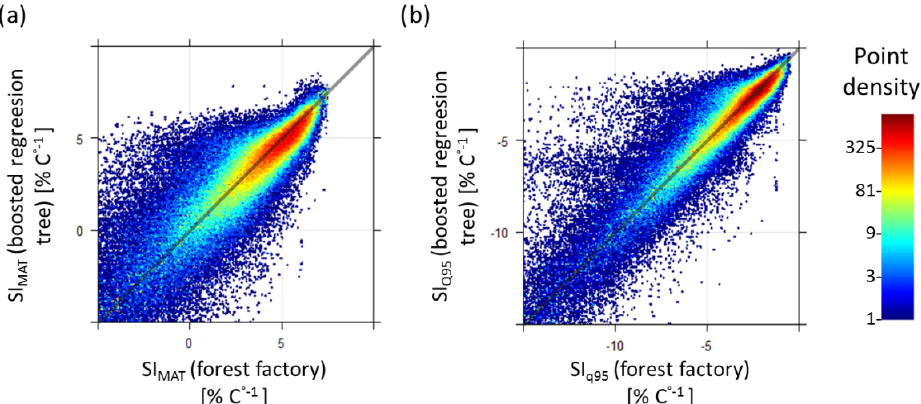
Figure B3. Comparison of temperature sensitivity calculations (SI MAT and SI Q 95 ) based on the forest factory and boosted regression tree model. Colours indicate point density. Diagonal is the 1 : 1 line. Panel (a) contains 90% of the forest factory data set and (b) contains 93% of the forest factory data